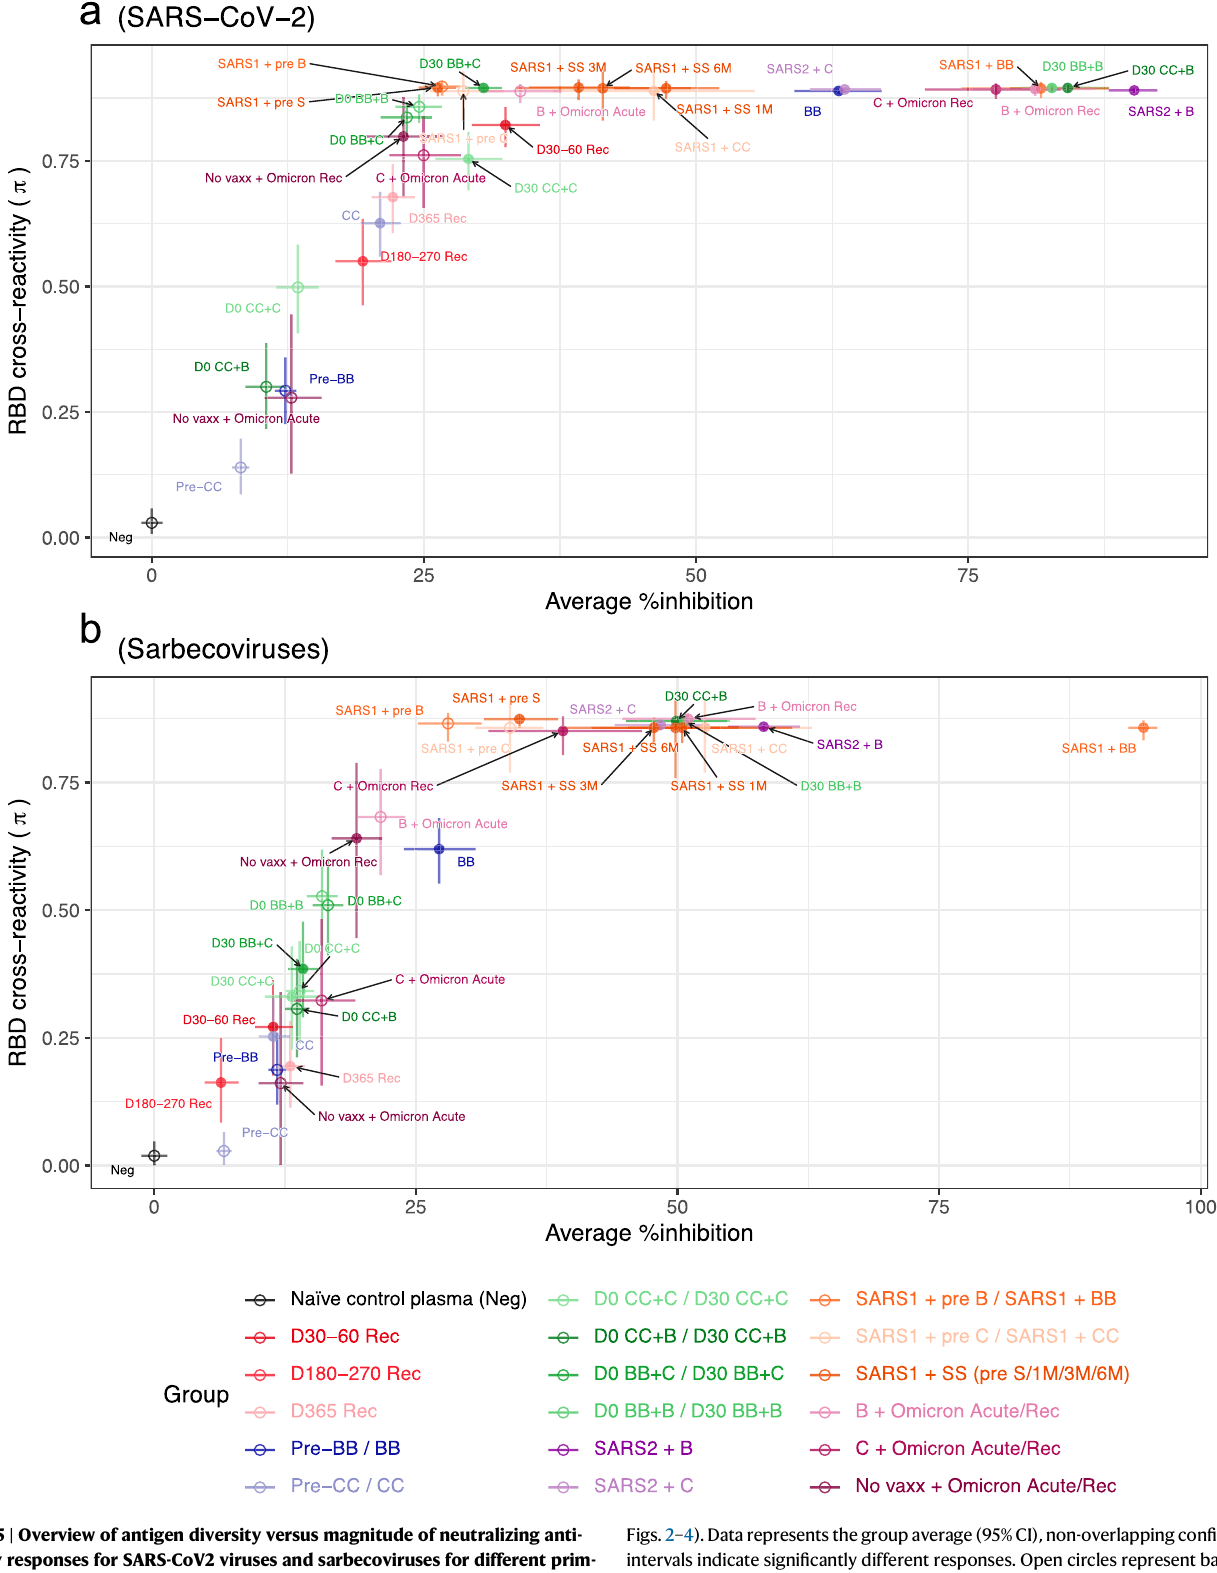
Figs.2 – 4).Datarepresentsthegroupaverage(95%CI),non-overlappingcon fi dence intervals indicate signi fi cantly different responses. Open circles represent baseline samples at pre vaccination, pre third dose vaccination or acute infection samples. Closed circles represent post vaccination or post infection samples at recovered (Rec)